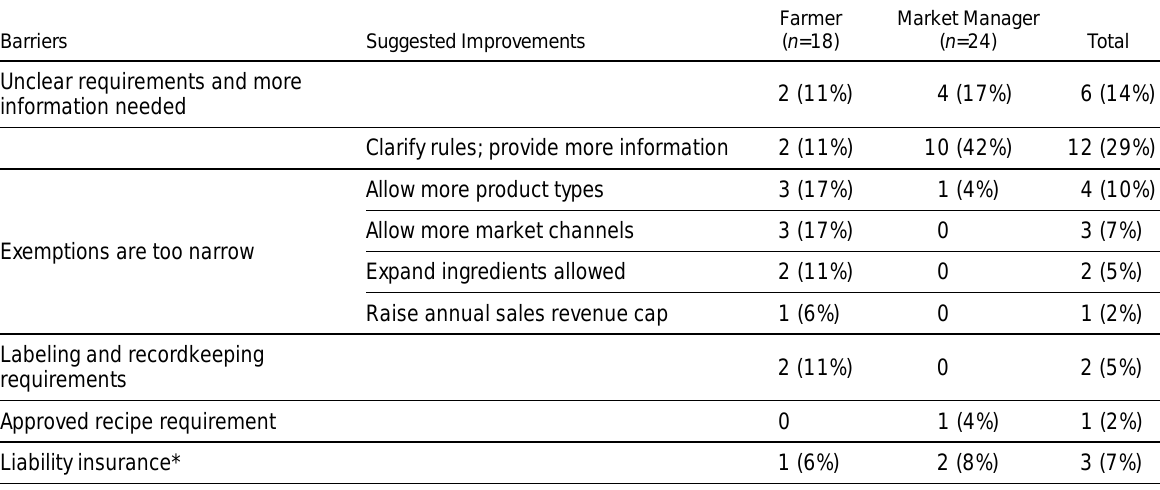
Table 4. Barriers and Suggested Improvements ( N